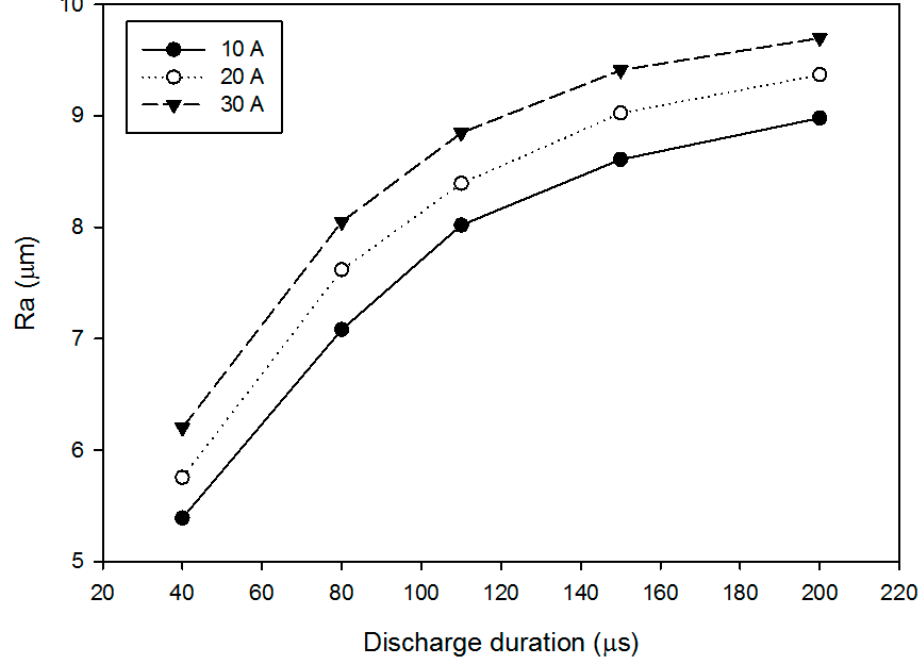
Figure 7. Effects of discharge time on surface roughness.